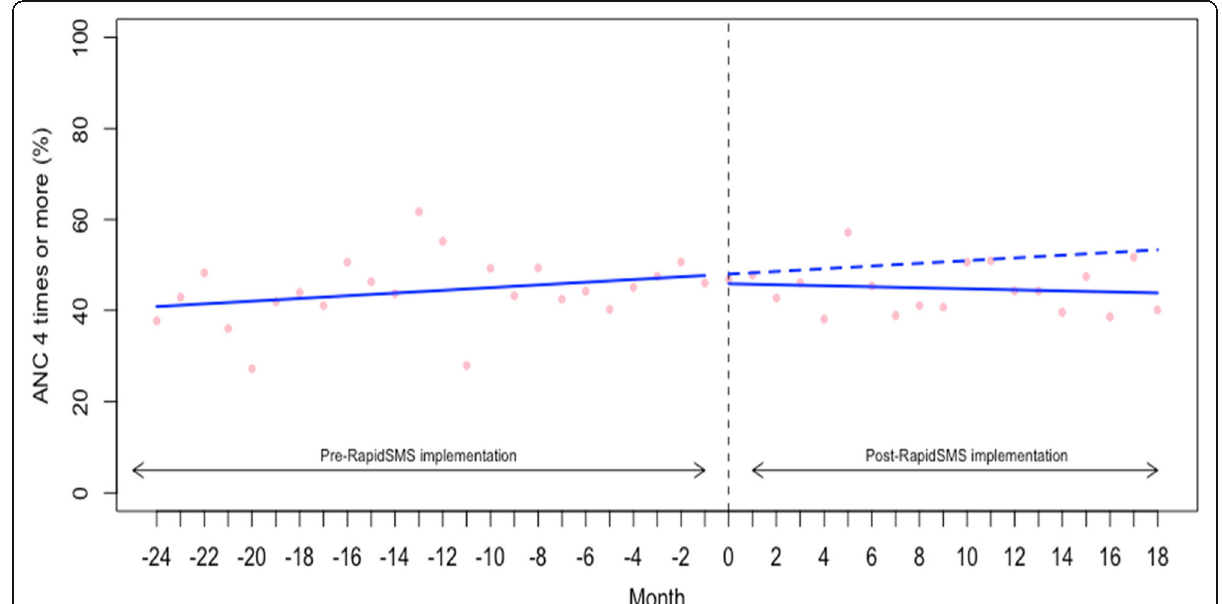
Fig. 2 Interrupted time series analysis of antenatal care (at least four visits) during